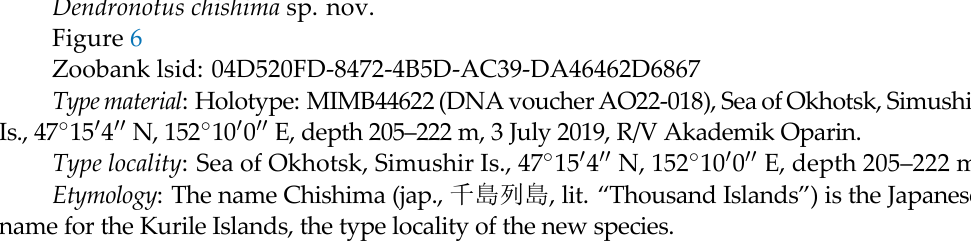
Zoobank lsid: 04D520FD‑8472‑4B5D‑AC39‑DA46462D6867 Type material : Holotype: MIMB44622 (DNA voucher AO22‑018), Sea of Okhotsk, Simushir